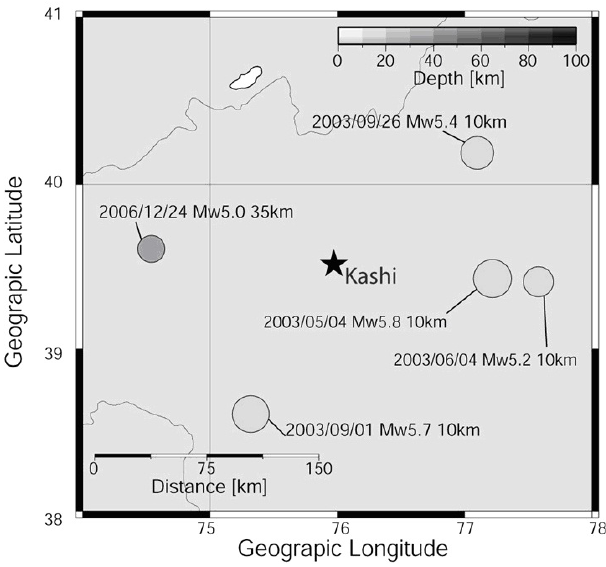
Fig. 1. The relative location of the ULF observation station (Kashi, a black star) and EQs (1 September, 26 September 2003; 4 May and 4 June 2003; 24 December